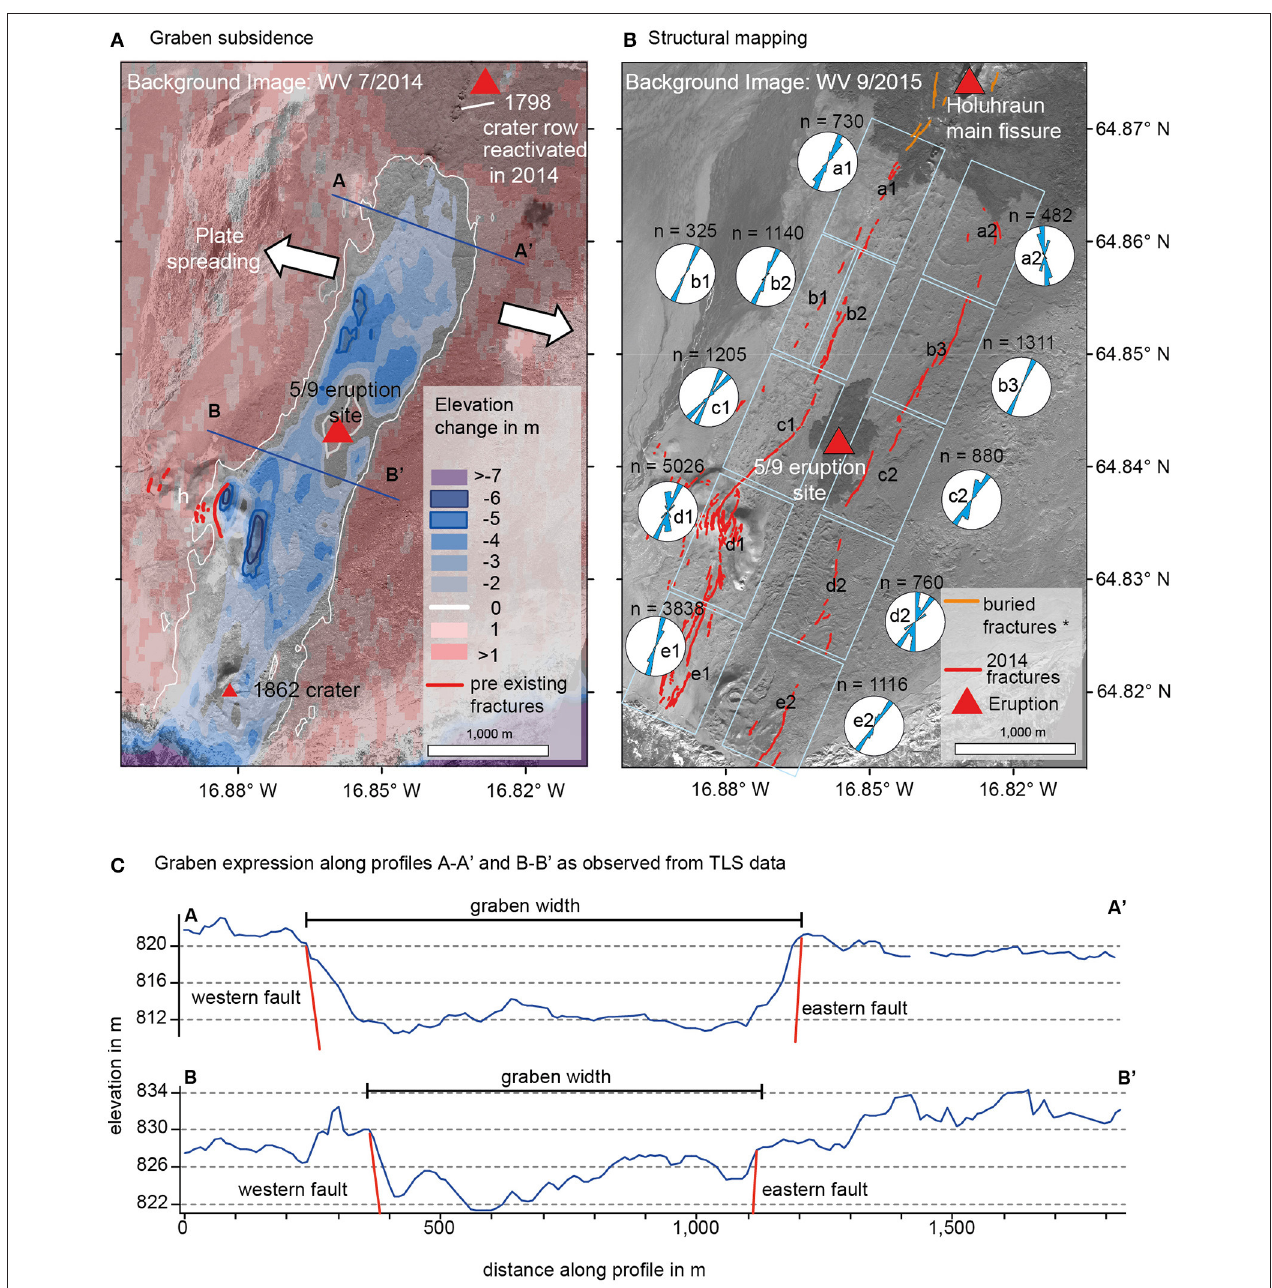
FIGURE 4 | Graben subsidence and structural mapping of (A) uplift (in red) and graben subsidence (in blue) based on a comparison of TanDEM-X data from November 2011 and September 2014. The background image is a WorldView-2 image acquired prior to the eruption in July 2014. Note that the location of the old crater row in the north corresponds exactly to the site of the 2014 Holuhraun fissure. The red lines indicate fractures that were identified using pre-eruptive WorldView-2 data. The average plate spreading direction (104 ◦ azimuth) is indicated by white arrows. (B) Structure lineament mapping results and associated strike directions of fractures, grouped (light blue boxes) along both boundary faults on either side of the graben. The red lines indicate the newly formed fractures, as observed from WorldView-2 post-eruptive data (acquired in September 2015), and orange lines indicate the pre-eruptive fractures observed by Hjartardottir et al. (2016). Note the hourglass-like fracture convergence at the 5th September eruption site and the fracture convergence toward the 2014 Holuhraun main eruptive site in the north. The strike directions of the fracture groups are shown by rose plots in 10 degree classes, weighted by fracture length, where n corresponds to the accumulated fracture segment length for this fracture group in m. (C) Graben profiles drawn normal to the graben along A–A ′ and B–B ′ display variations in graben width and shape. While the graben has a symmetric shape in the northern profile, it comprises a tilted block or half graben formation in the southern profiles, thus confirming that reactivation and higher deformation have occurred on the western